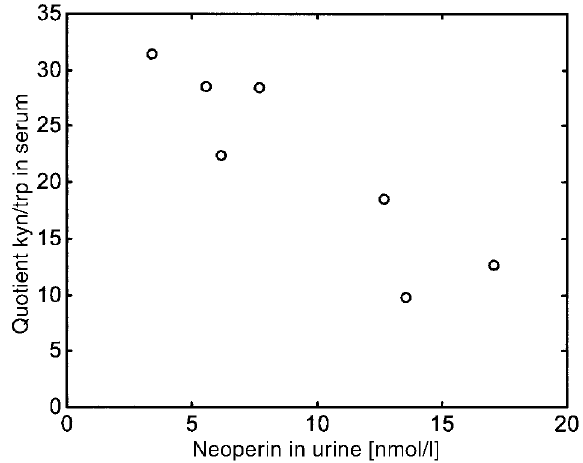
FIG. 1. Kynurenine-per-tryptophan (kyn/trp) quotients meas- ured in serum versus concentration of neopterin in urine (baseline values).